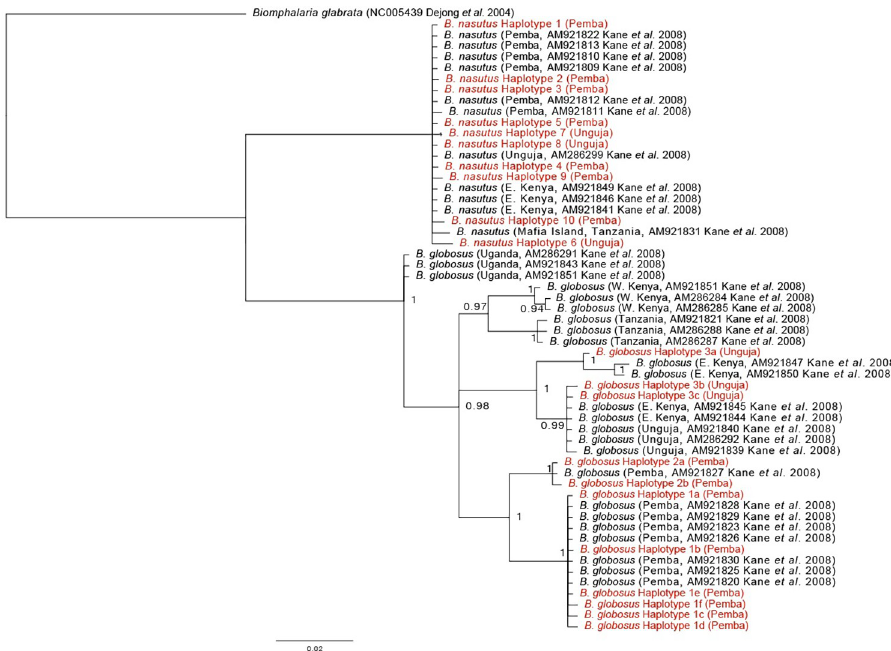
Fig 3. Bayesian inference of the partial mitochondrial cox 1 haplotype dataset of Bulinus nasutus and B . globosus collected from Unguja and Pemba. Reference data from East Africa (Kane et al . [42]). Tree produced using Bayesian inference using MrBayes v3.2.7A [51] under the HKY+I+G model (-lnl 2020.2144, AIC 4052.4287). Branches < 0.95 posterior probability collapsed. The branch length scale bar indicates the number of substitutions per site. Text in red indicates Bulinus haplotypes generated from the current study as listed in S2